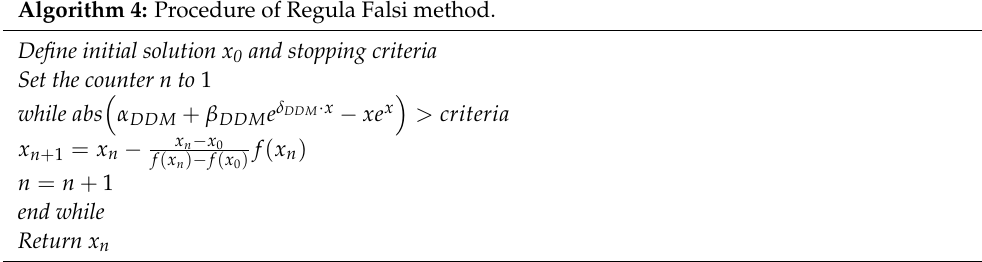
Algorithm 4: Procedure of Regula Falsi